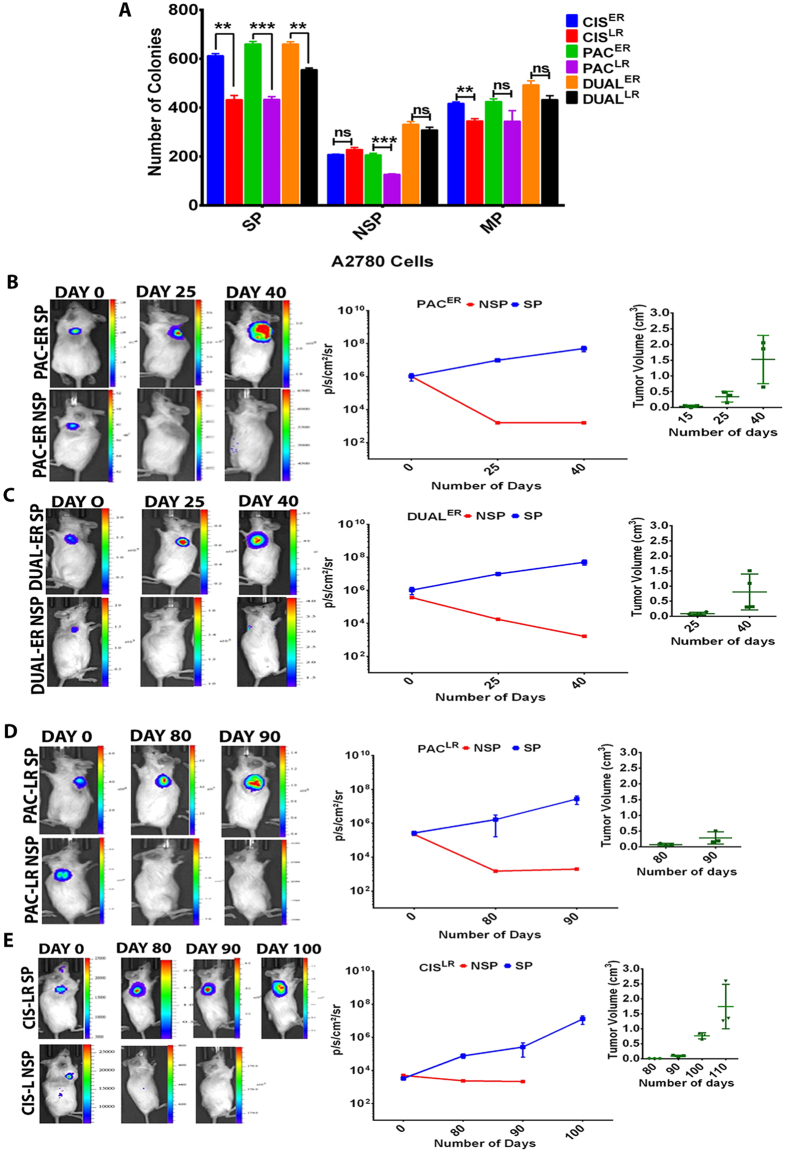
Monitoring tumorigenic properties of SP/NSP cells from early and late resistant stages of A2780 resistant models in real time.(A) Bar graph showing significant increase in the clonogenic potential of ER-SP cells than LR-SP cells. (B,C) Representative bioluminescence images of early resistant cells (PacER and DualER) from day 0 to day 40 and graphical representation showing increased bioluminescence signal and tumor volume by SP cells. NSP cells showed significant decrease in bioluminescence and absence of tumor formation (p < 0.05), [Data represented as ± SEM for n = 3]. (D,E) Representative bioluminescence images of late resistant cells (PacLR and CISLR) from day 0 to day 90 and graphical representation showing increased bioluminescence signal and tumor volume by SP cells. NSP cells showed significant decrease in bioluminescence signal and absence of tumor formation (p < 0.05) [Data represented as ± SEM for n = 3].